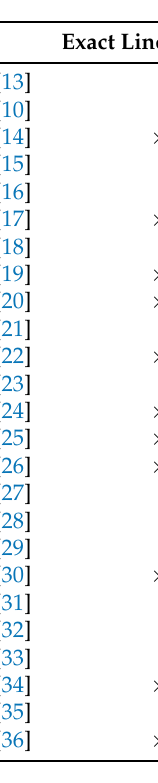
Table 5. Common solution